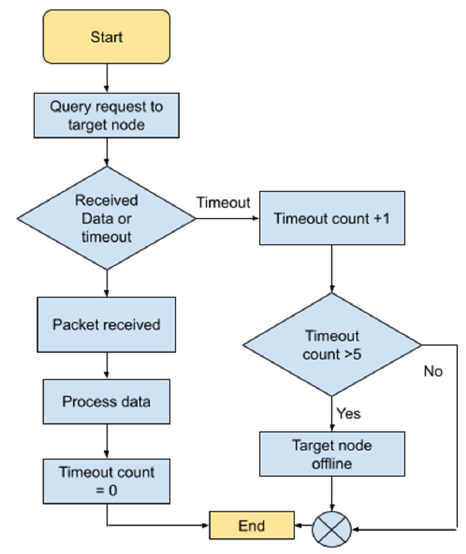
Figure 11. Query